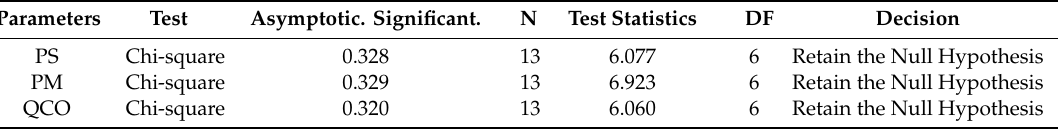
Table 8. Chi-square test statistics results.